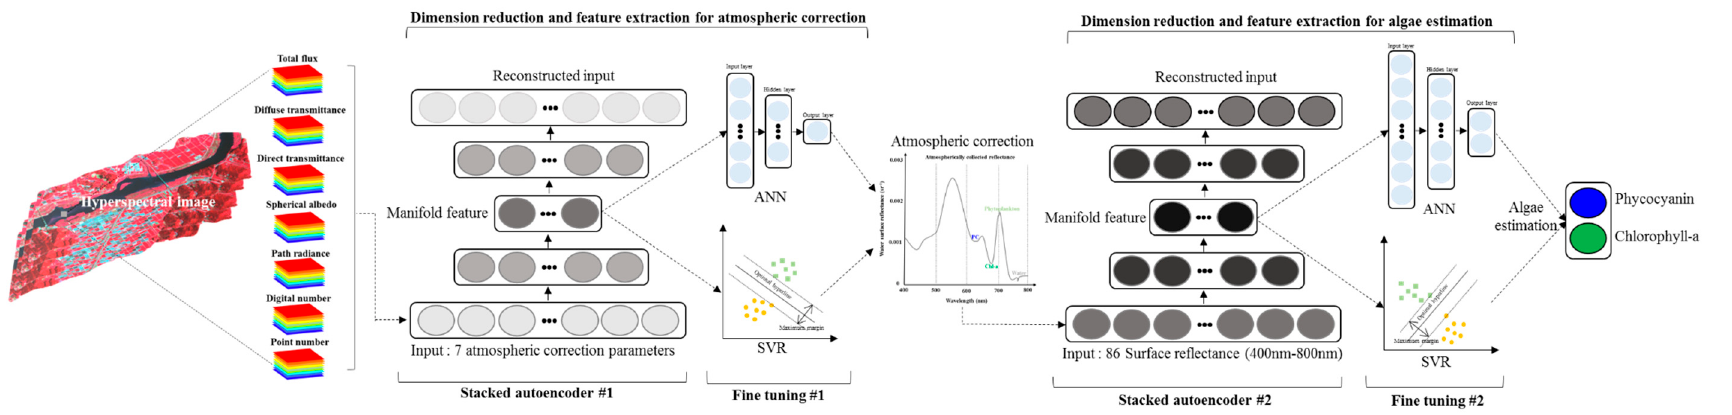
Figure 3. Stacked encoder with fine tunings (i.e., artificial neural network [ANN] and support vector regression [SVR]) for atmospheric correction and cyanobacterial estimation, stacked autoencoder#1 and fine tuning#1, for the water surface reflectance estimation using hyperspectral image data inputs including total flux, diffuse transmittance, direct transmittance, spherical albedo, path radiance, digital number, and point sample number, stacked autoencoder#2 and fine tuning#2 for the PC and Chl-a estimations, using atmospherically-corrected reflectance spectra.